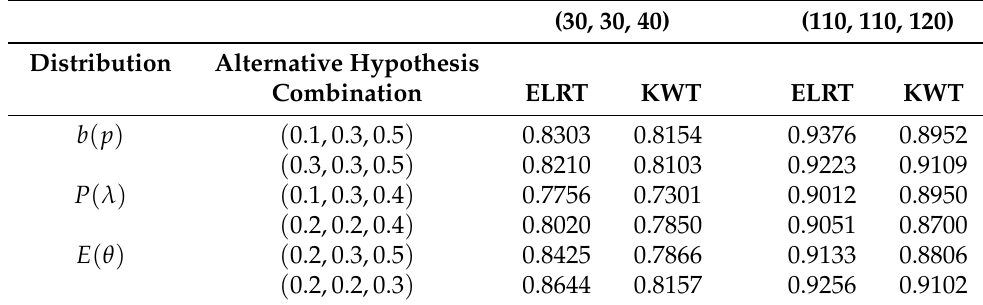
Figure 6. θ 0 = 1, the sample size is (110,110,120), the Q-Q plots of ELRT and KWT for the overall comparison of the 3 exponential distributions. Table 2. Rejection rates of ELRT and KWT under sample sizes ( 30,30,40 ) and ( 110,110,120 ) and different alternatives indicated in terms of parameters.